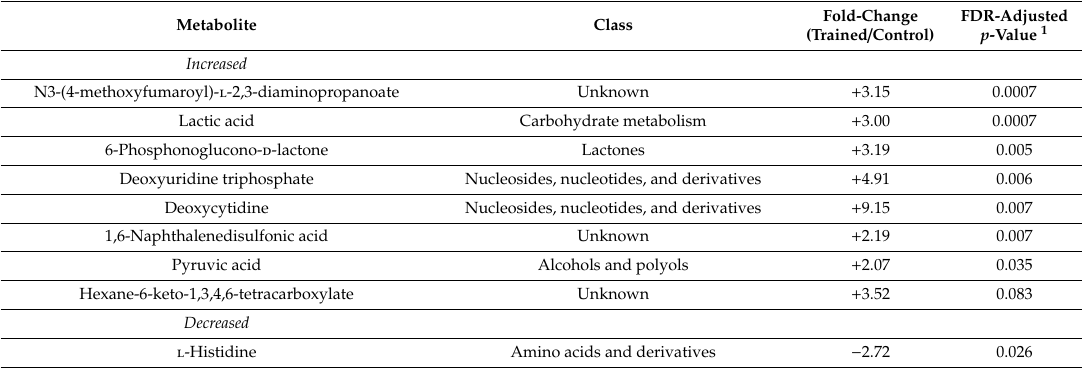
Table 2. Significantly altered metabolites between the trained and control group at T = 0 (30 min after initiation of the breathing exercises and prior to LPS